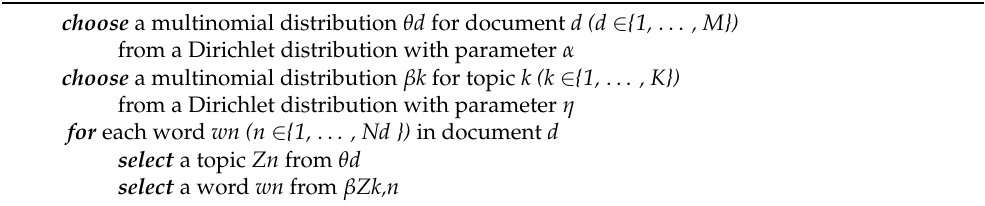
Table 1. Pseudocode of LDA generative process.